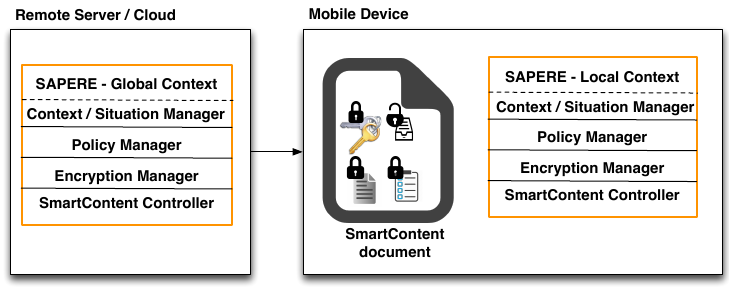
Figure 12. Policies and decisions granted from both local and remote locations.